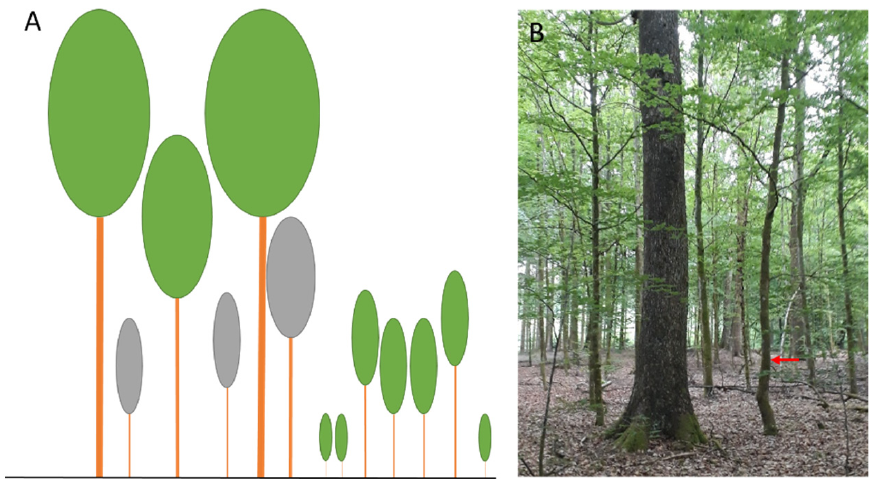
Figure 4. Tree detectability status assessment: ( A ) forest stand and overtopped trees (grey); ( B ) picture of an overtopped tree on the field (indicated by the red arrow).